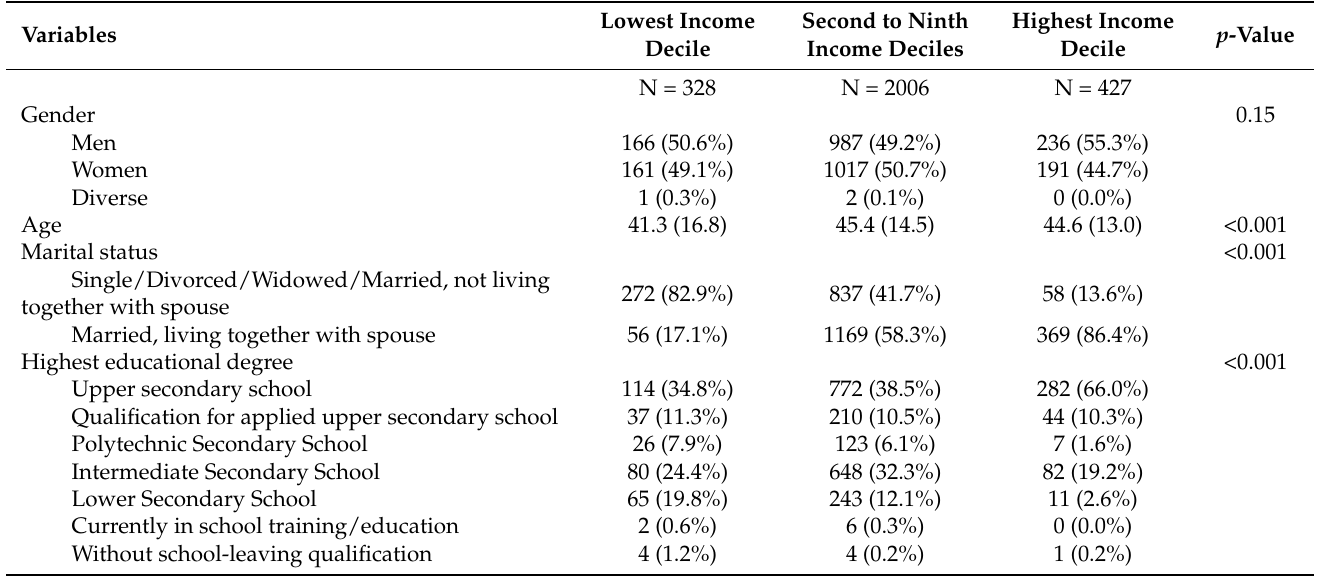
Table 1. Sample characteristics stratified by income